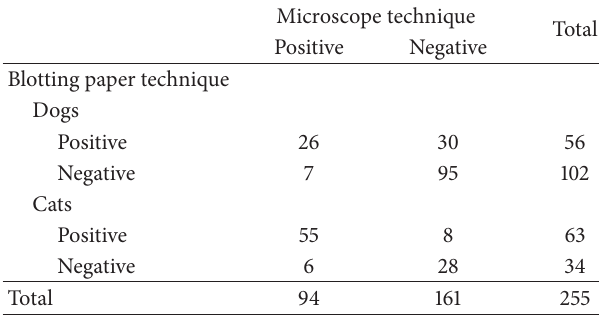
Table 1: Results of the examination of the coat brushing material using two techniques in dogs and